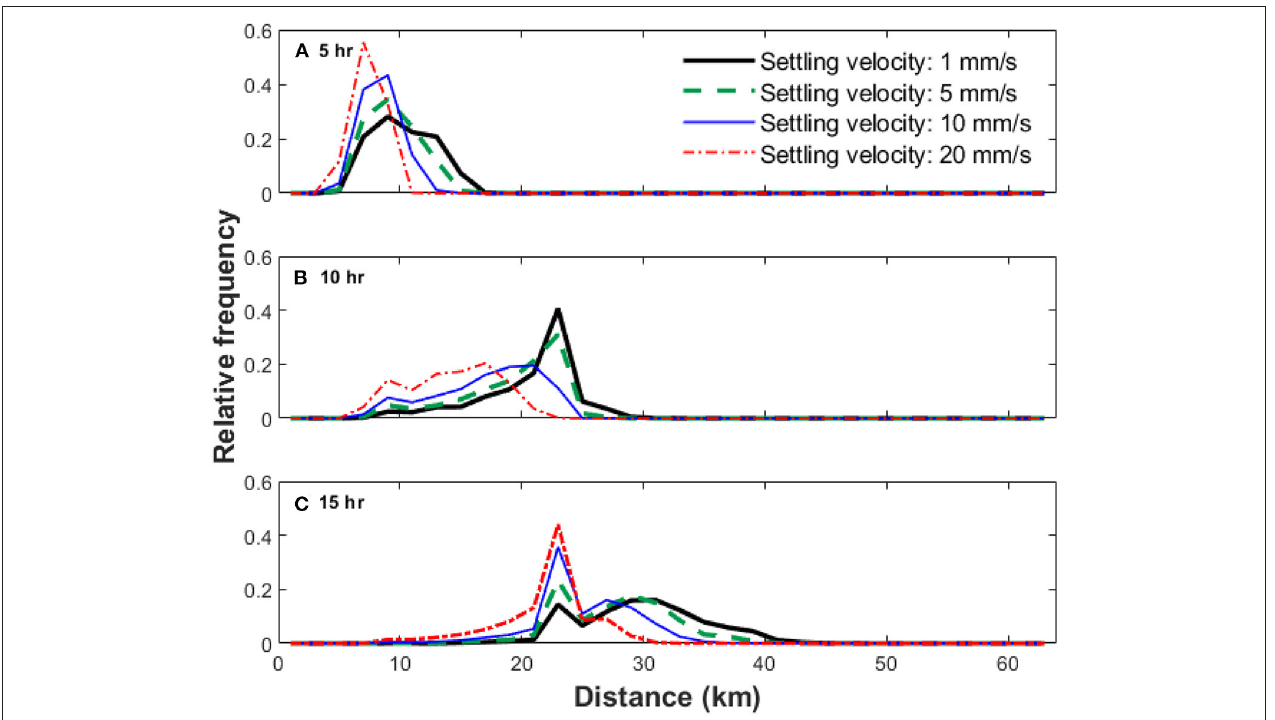
FIGURE 7 | Longitudinal distribution of suspended oil-particle aggregates (OPA) under critical shear stress of 0.1 Pa and four settling velocities; 1, 5, 10, and 20 mm/s. Results at the end of: (A) 5 h, (B) 10 h, and (C) 15 h after the oil spill. The resolution of the plots is 2